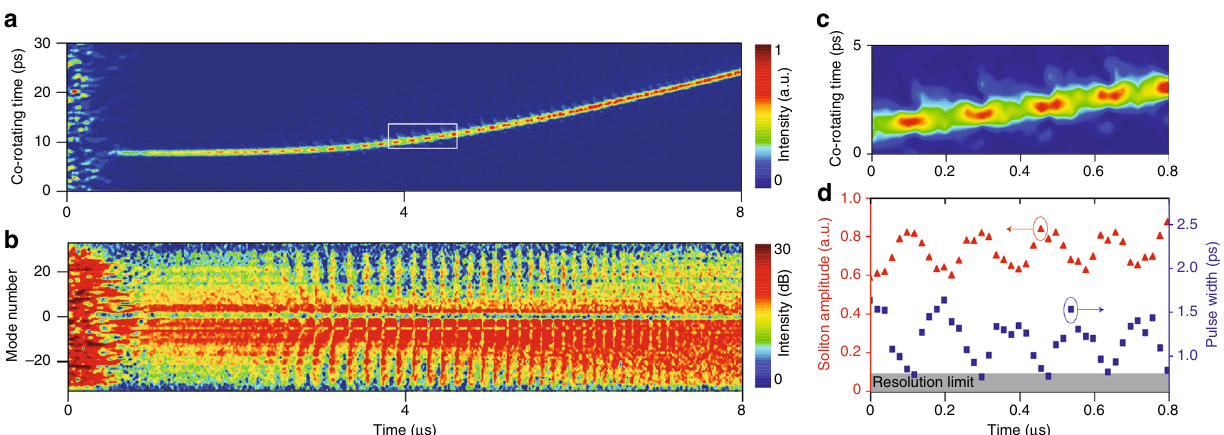
Fig. 3 Temporal and spectral measurements of breather solitons. a Motion of a single soliton state showing peak power breathing along its trajectory. b Spectral dynamics corresponding to a . The y -axis is the relative longitudinal mode number corresponding to speci fi c spectral lines of the soliton. Mode zero is the pumped microcavity mode. The soliton spectral width breaths as the soliton peak power modulates. The spectrum is widest when peak power is maximum. c Zoom-in view of the white rectangular region in a . d Soliton amplitude and pulse width breathing corresponding to c . The frame rate is 50 MHz for all